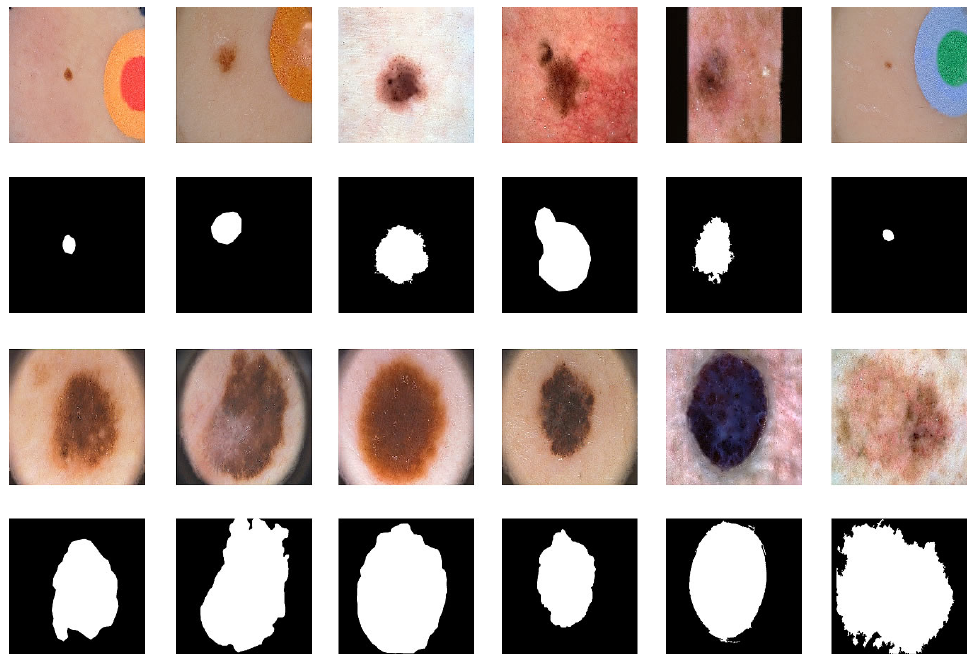
Figure 4. Examples of the segmentation data set.